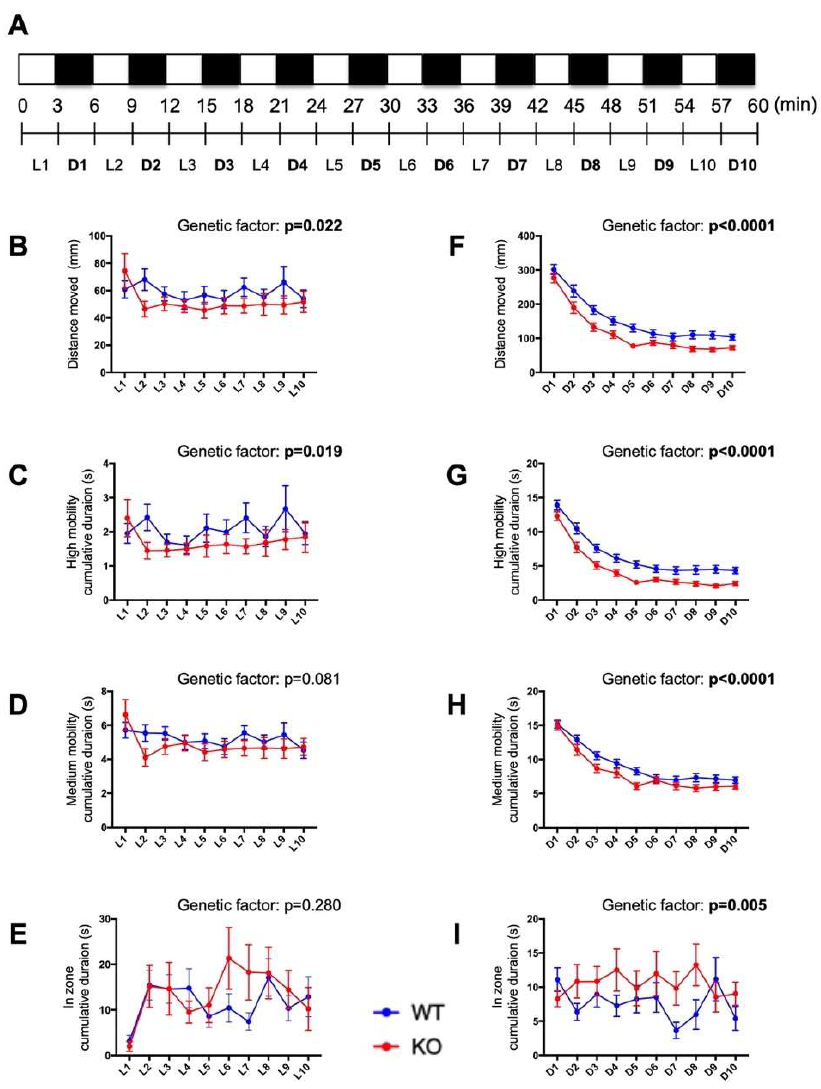
Figure 7. Impaired behavioral responses to light–dark cycling in c3orf70-KO zebrafish. ( A ) Overview of the behavioral analysis of the response to 3-min cycling between light and dark conditions. Behavior in c3orf70-WT or KO was assessed as: distance moved ( B , F ), cumulative duration at high mobility ( C , G ) and medium mobility ( D , H ), and cumulative duration in the center zone ( E , I ). Behavior during dark and light periods is shown in ( B – E ) and ( F – I ), respectively. Data are presented as the mean ± SEM of n = 40 for WT and n = 41 for KO.